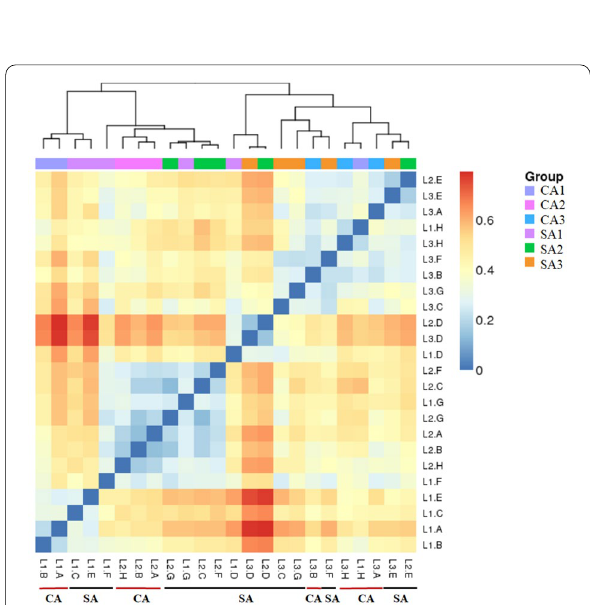
Fig. 5 Temporal variations in the beta diversity of the soil bacteria inhabiting litchi orchards that were maintained under conventional (CA) and sustainable (SA) agricultural practices. 1, 2 and 3 indicate successive trimester samplings carried out on October 2016, January 2017 and April 2017, respectively. Beta diversity with weighted UniFrac analysis between October 2016 and April 2017 was measured by software QIIME (v1.80). Beta diversity heat map was generated by the R software in the NMF